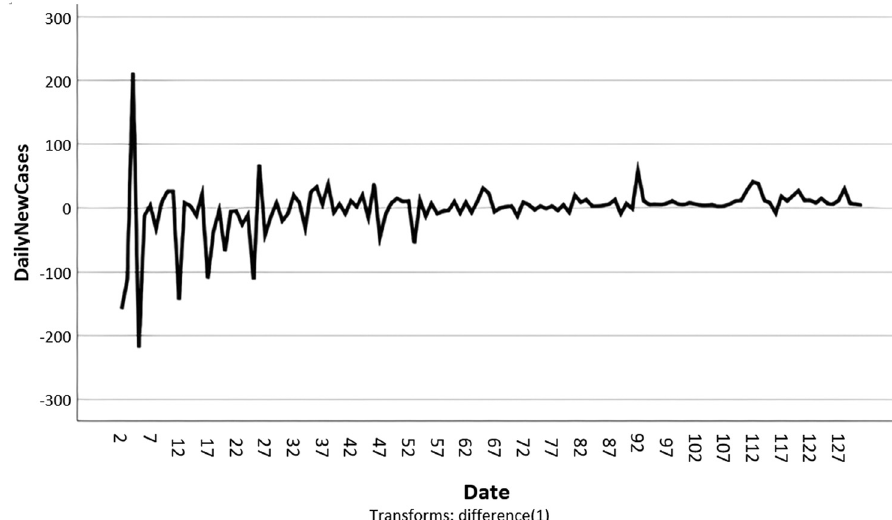
Figure 3: The di ff erenced series.